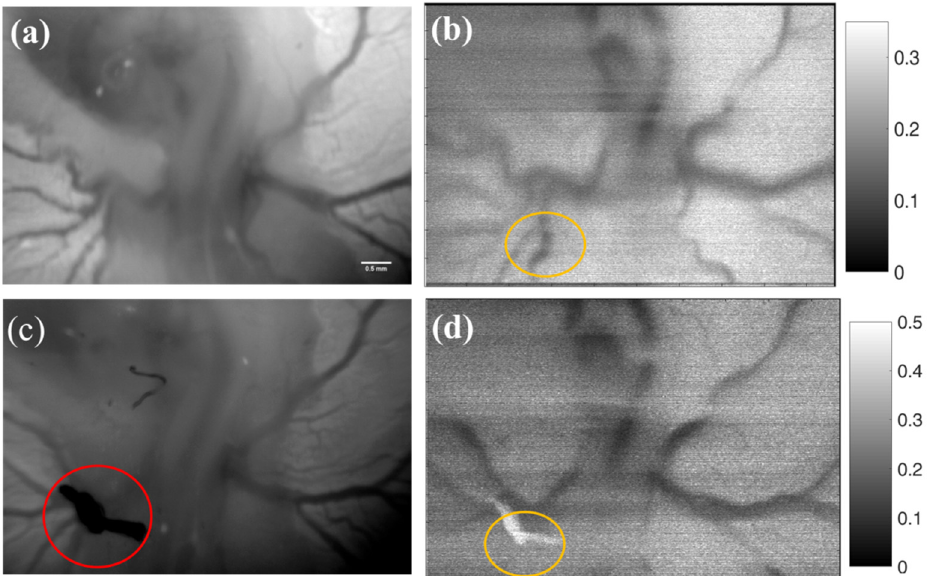
Figure 6 . ( a ) A wide-field image of the chick embryo (day 3) with white light illumination. ( b ) The corresponding laser speckle contrast image using LS-SSCI before clipping. ( c ) The intensity image of the same chick embryo after vascular clipping. The silk suture is indicated in the red circle. ( d ) The corresponding laser speckle contrast image using LS-SSCI after clipping. The vessel in the yellow circle is more visible in ( b ) compared to ( d ). The image area is 4.26 mm × 6.78 mm.